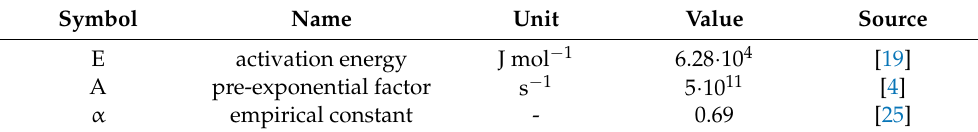
Table 4. Reaction kinetic